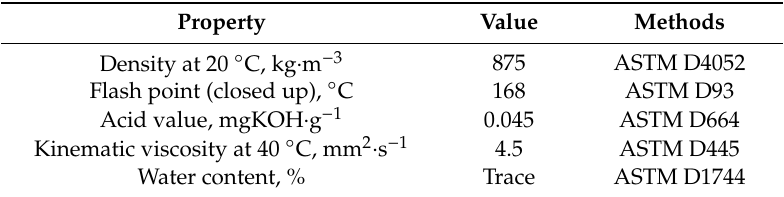
Table 1. Physical properties of the